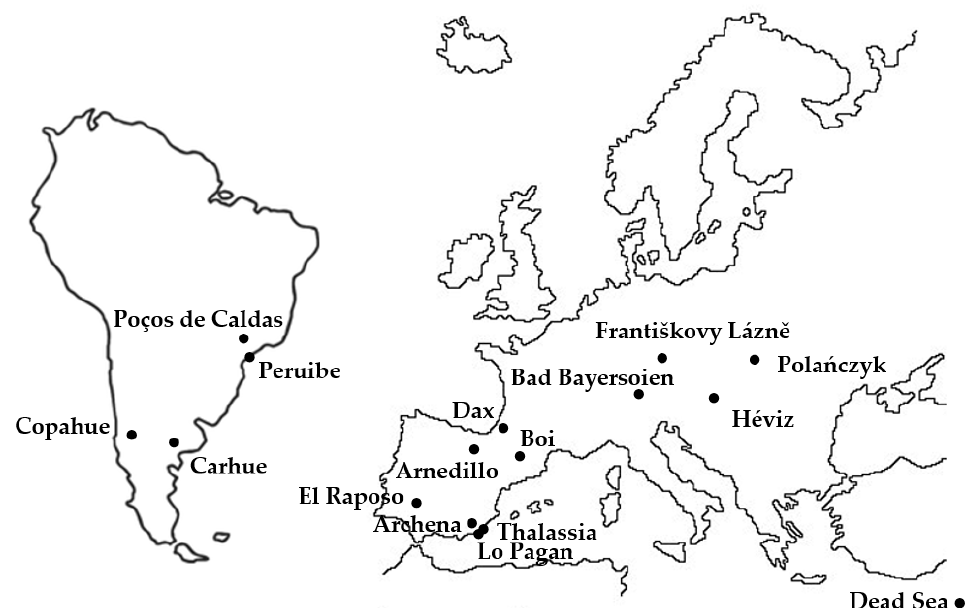
Figure 1. Origins of the peloids used in medical spas (MSs).